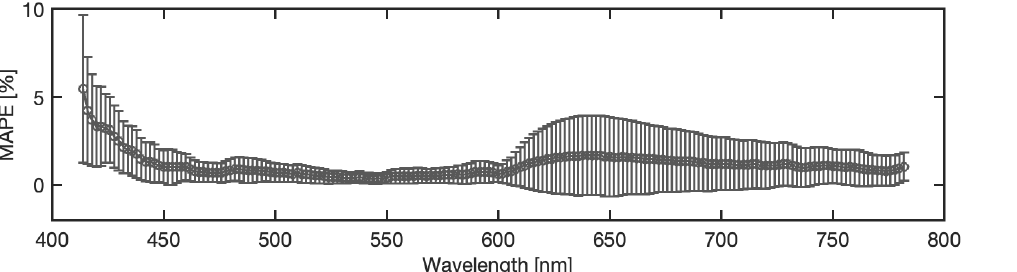
Figure 13. MAPE as a function of wavelength with standard deviation.